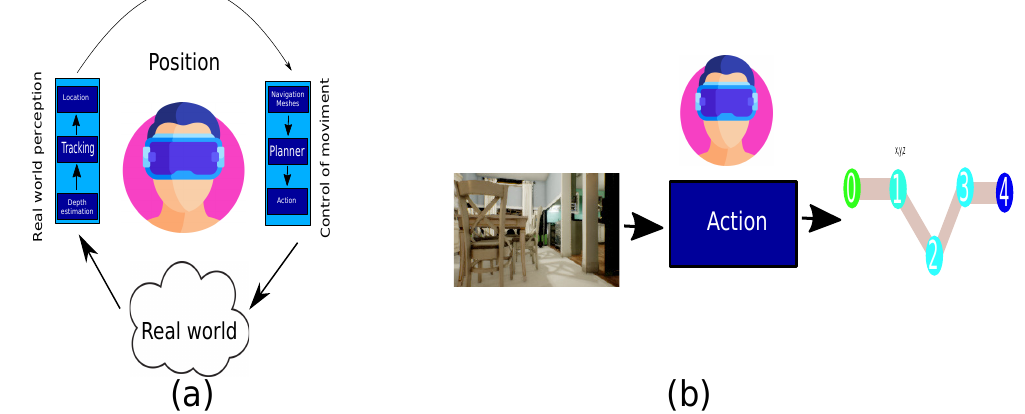
Figure 2. Path generator architectures. ( a ) Conventional architecture. ( b ) Reduced architecture.